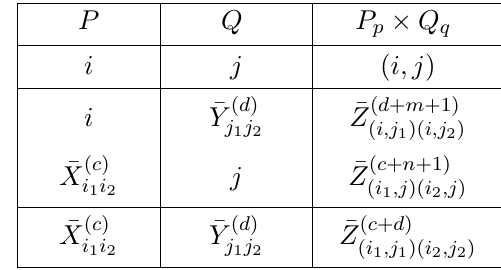
Figure 5 : The four cases of elements of P and Q giving rise to elements of P p